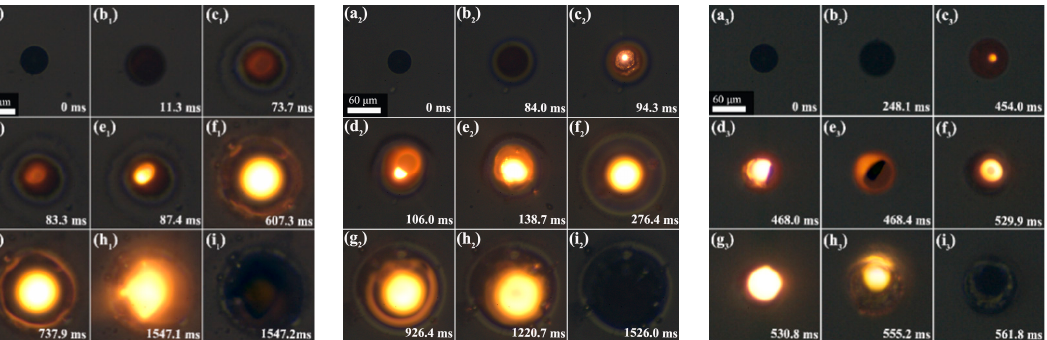
Figure 11. Representative snapshots of flame sequences during the whole combustion process of single Al-Li alloy microparticles at 0.4 MPa (left ( a 1 – i 1 ) ), 0.6 MPa (middle ( a 2 – i 2 ) ), and 0.8 MPa (right ( a 3 – i 3 )).